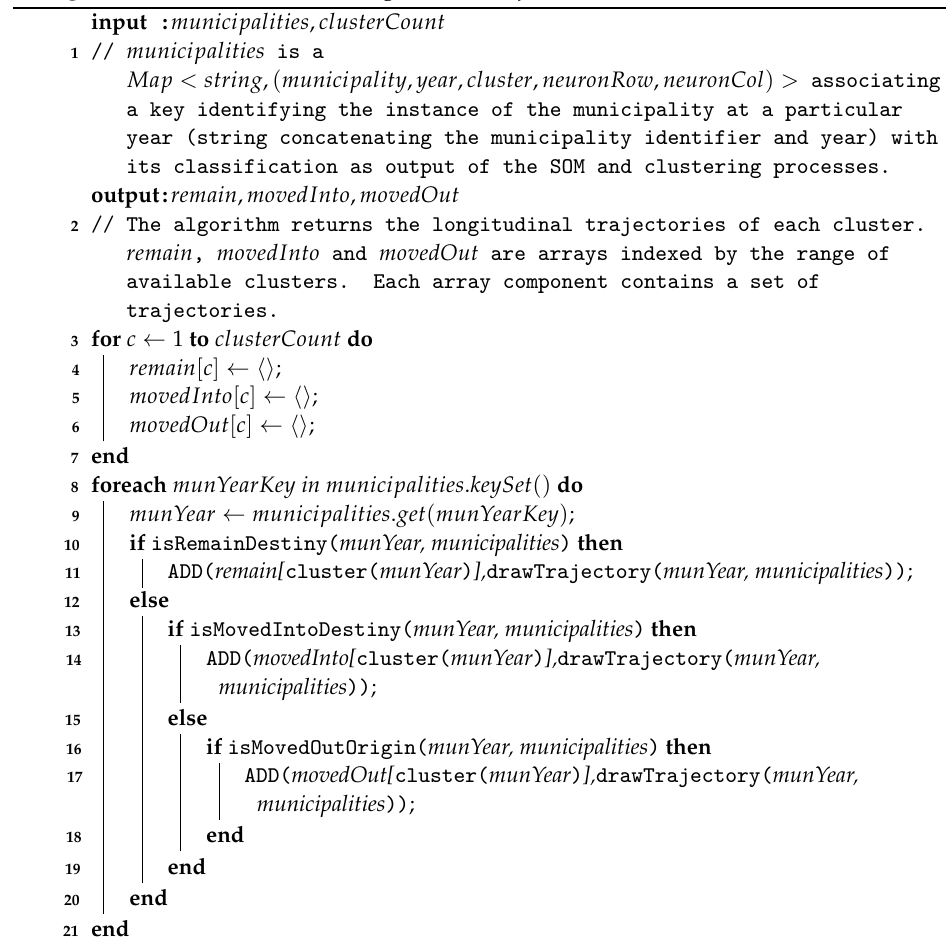
Algorithm 1: Generation of longitudinal